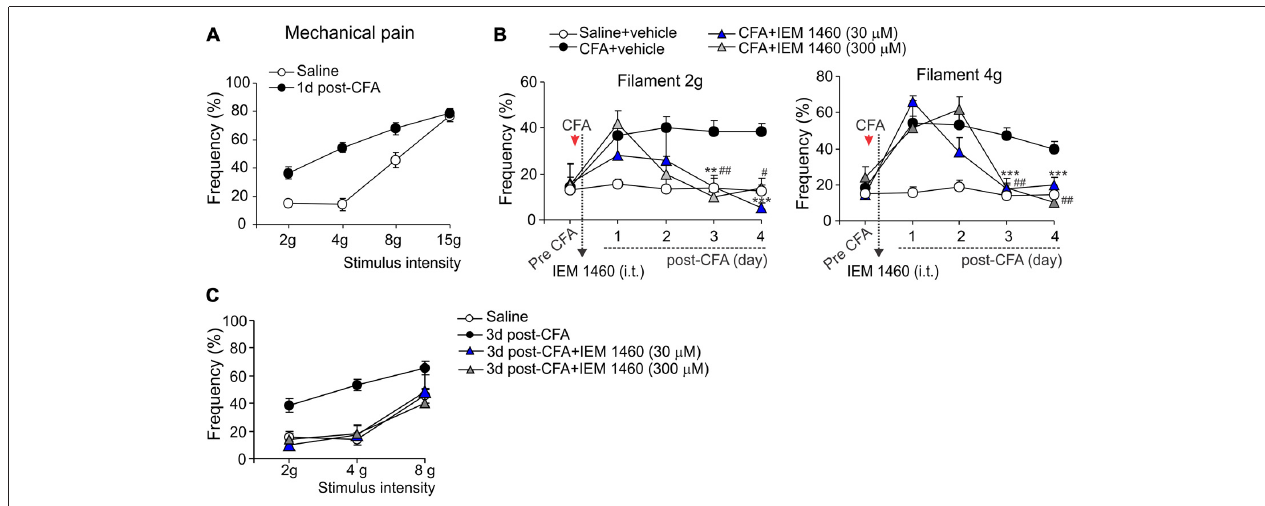
FIGURE 2 | Analgesic effect of IEM-1460 on the inflammatory-induced mechanical hypersensitivity. (A) von Frey behavioral test demonstrates tactile allodynia in the CFA-inflamed rats in response to von Frey monofilaments of different stimulus intensity. (B) Treatment with IEM-1460 recovered the paw withdrawal frequency in response to the 2 g (left graph) and 4 g (right graph) von Frey monofilaments. Results are presented as mean ± SEM. ∗∗ p < 0.01, ∗∗∗ p < 0.001 for 30 µ M of IEM-1460 vs. the correspondent time-point in the CFA-inflamed group. # p < 0.05, ## p < 0.01 for 300 µ M of IEM-1460 vs. the correspondent time-point in the CFA-inflamed group. One-way ANOVA and Bonferroni post hoc test. (C) Post-treatment with IEM-1460 recovered tactile allodynia in the CFA-inflamed rats after 3 days of